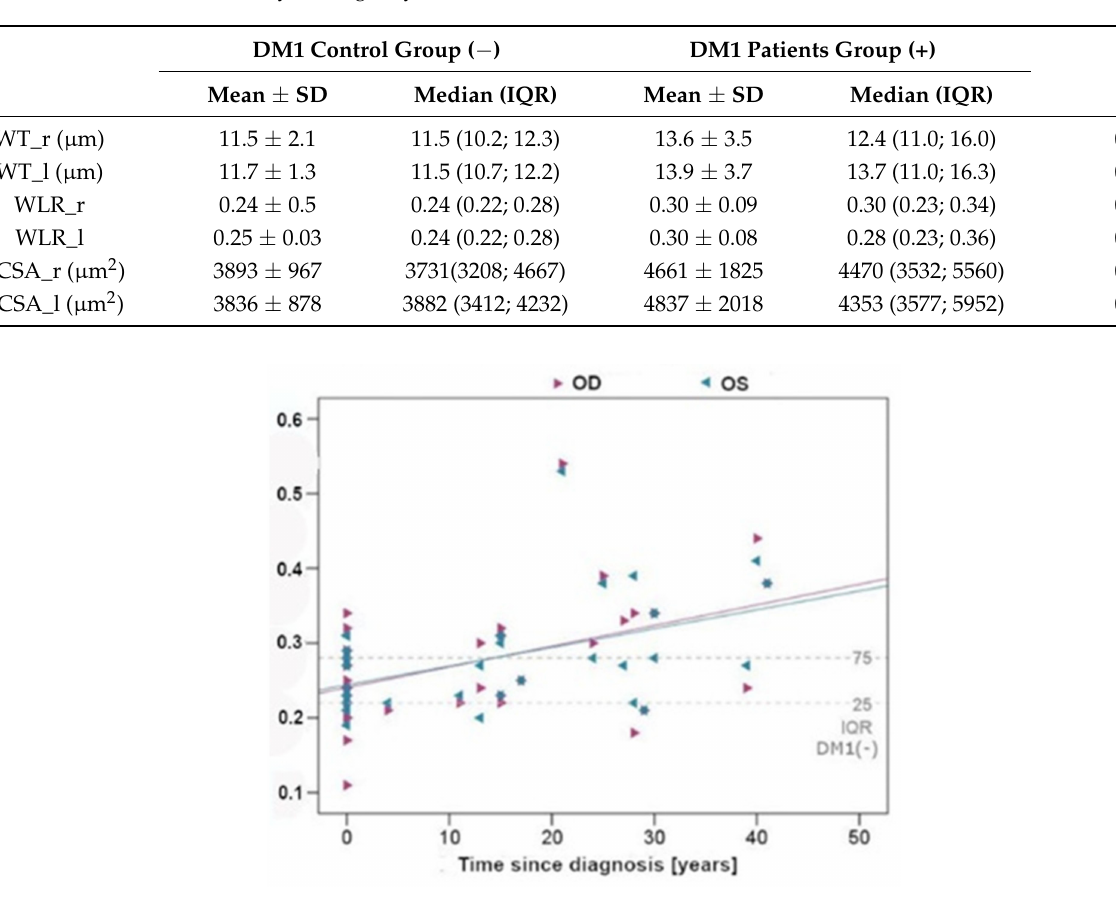
Table 3. WT, WLR, and WCSA values in the DM1 group (DM1+) and the control group (DM1 − ); left eye (l), right eye (r).